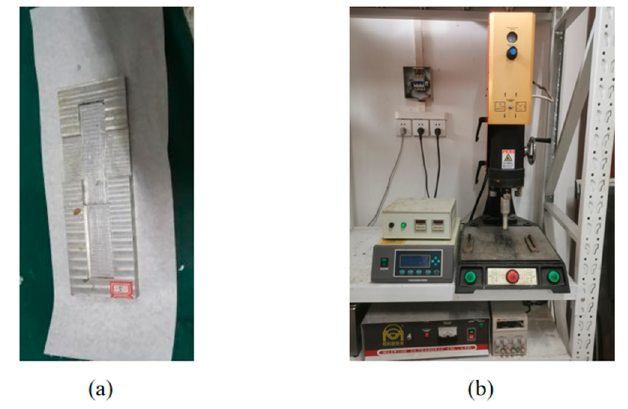
Figure 1. The fixture ( a ) and ultrasonic workbench ( b